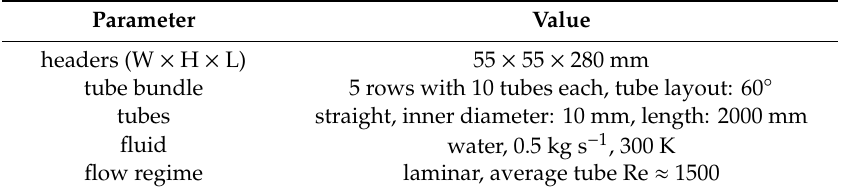
Figure 1. Schematic of the flow distribution system from Table 1.